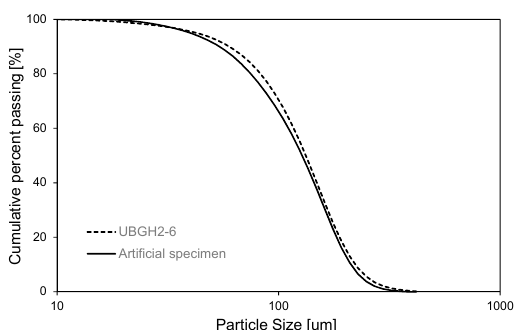
Figure 2. Particle size distribution of the UBGH2-6 core sample and artificial specimen.